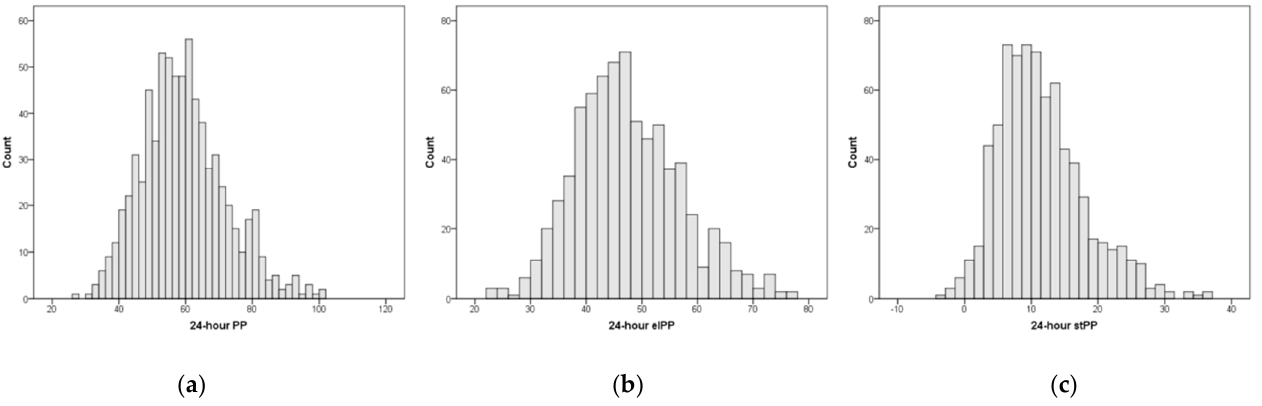
Figure 1. Distribution of 24 ‐ hour pulse pressure (PP) ( a ), elastic PP (elPP) ( b ) and stiffening PP (stPP) ( c ) in the study population.